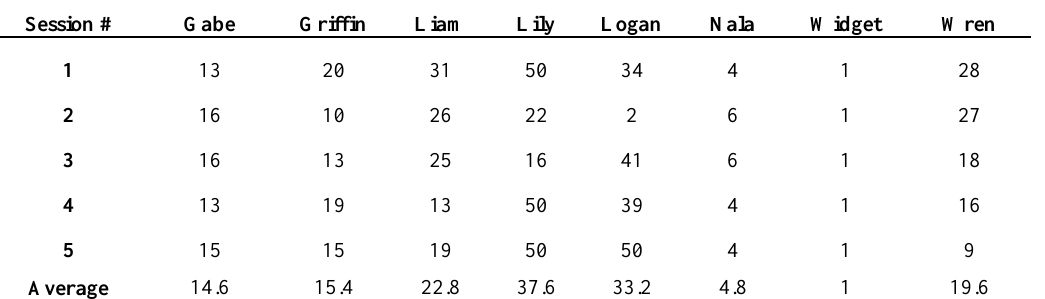
Accumulation Test Performance from Experiment 1 (Total Number of Pellets Accumulated; Maximum Possible: 50 Pellets) for the Five Free Accumulation Sessions Session # Gabe Griffin Liam Lily